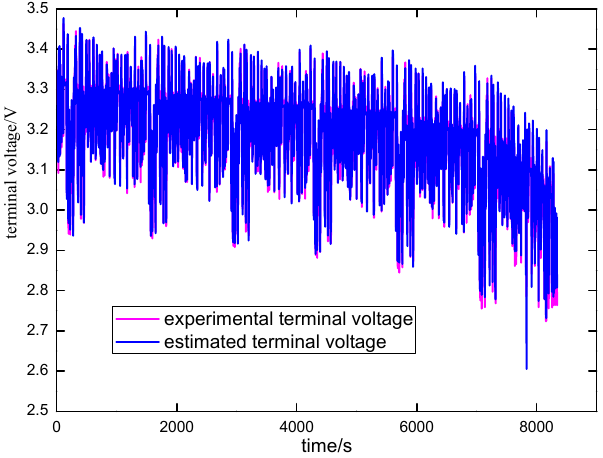
Figure 9. The estimated terminal voltage and the experimental terminal voltage of the PCBG with two cells.